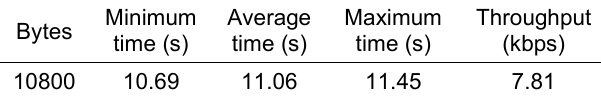
Figure 11. Data Fragment screen of the developed application. (a) Options to download the data. (b) Dialog that appears when downloading. (c) After